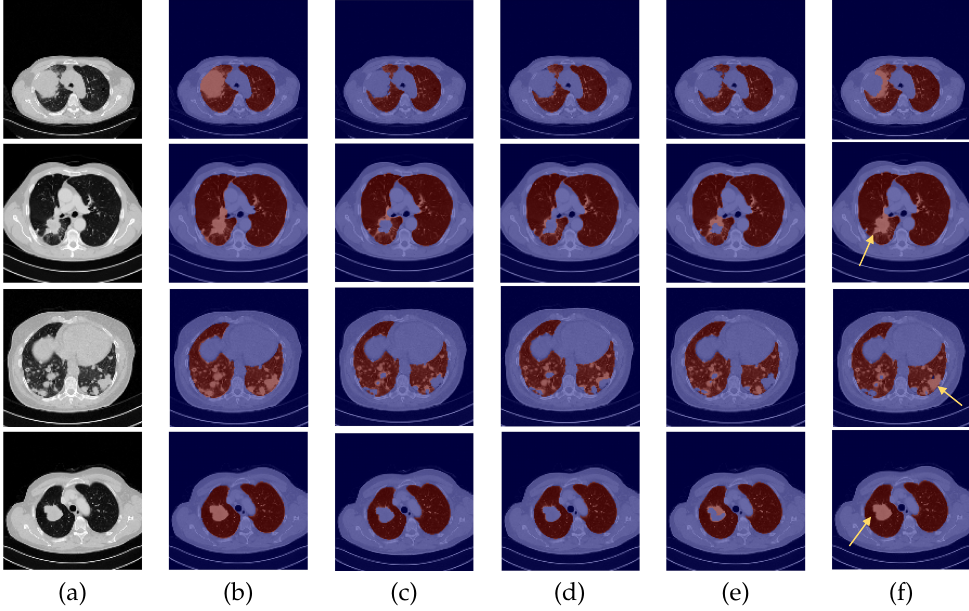
Figure 6. Examples of CHUSJ scans. From left to right: ( a ) CT original image; ( b ) ground-truth (G-T); ( c ) baseline prediction; ( d ) #2 with DC and without DA predicted mask; ( e ) #3 with DA and without DC predicted mask; ( f ) and #4 with DA and DC predicted